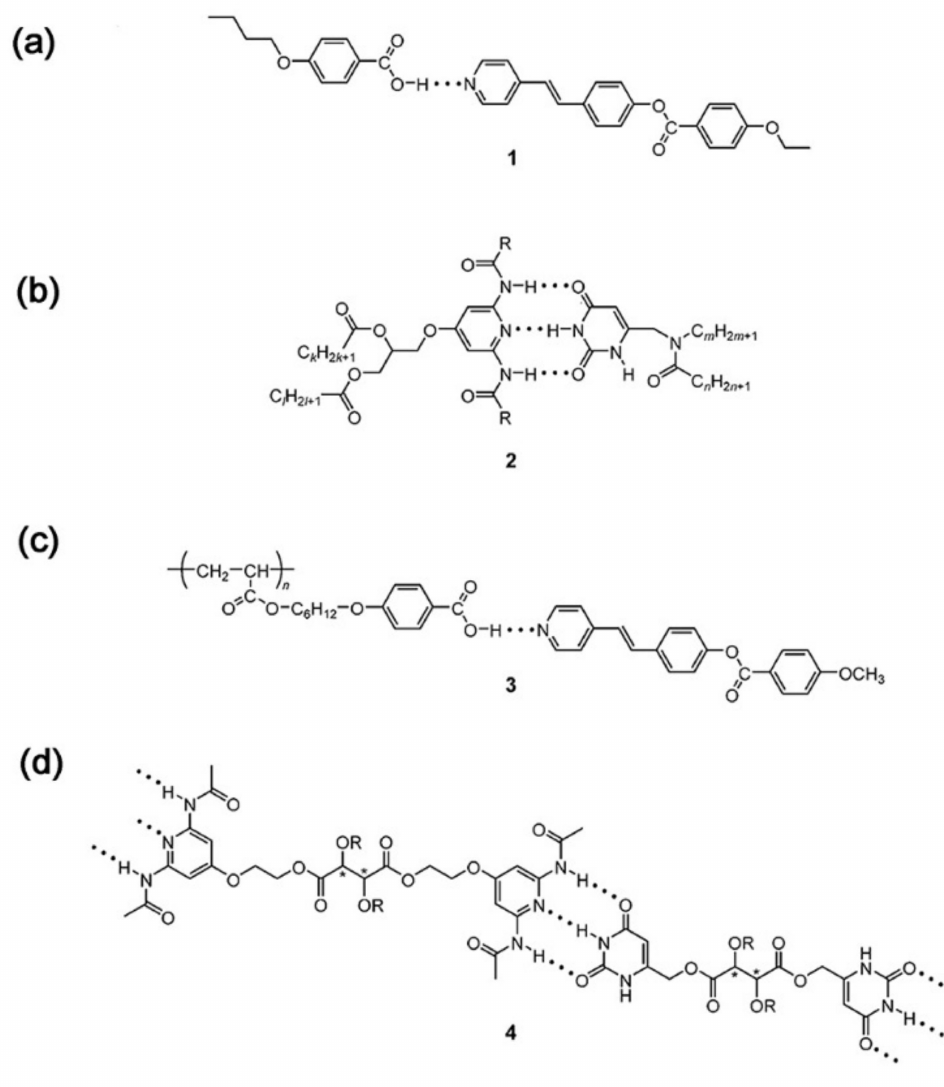
Figure 1. Supramolecular hydrogen-bonded liquid crystal (LC) molecules: ( a ) Low molecular weight complex by Kato and Fre’chet in 1989. Reprinted with permission from reference [80]. Copyright (1989) American Chemical Society. ( b ) Low molecular weight complex by Lehn and coworkers in 1989. Reprinted with permission from reference [81]. Copyright (1989) Royal Society of Chemistry. ( c ) Side-chain polymer by Kato and Fre’chet in 1989. Reprinted with permission from reference [82]. Copyright (1989) American Chemical Society. ( d ) Main-chain polymeric complex by Lehn and coworkers in 1990. Reprinted with permission from reference [83]. Copyright (1990) John Wiley and